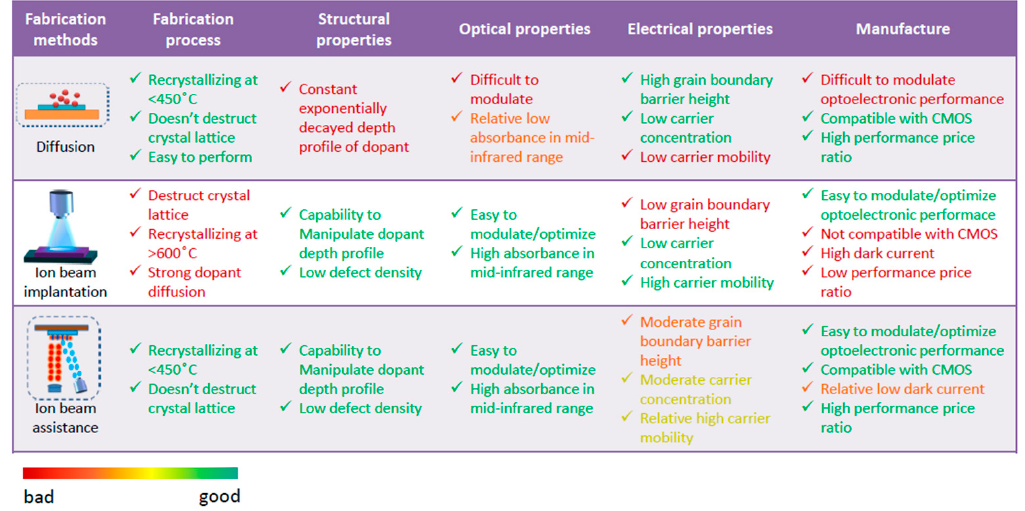
Figure 15. The summaries and comparisons of different sensitization methods.